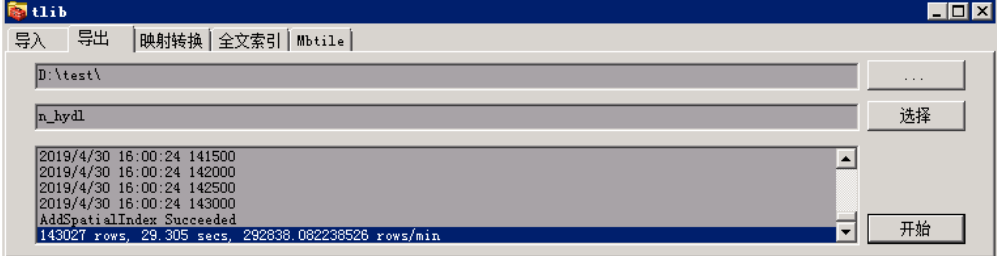
Figure 9. Bulk migration of data into a data cluster. Through this migration method, the historical data in ArcGIS and Oracle can be conveniently imported into BiGeo for analysis, and the analysis results are exported back to the original software for continued application.